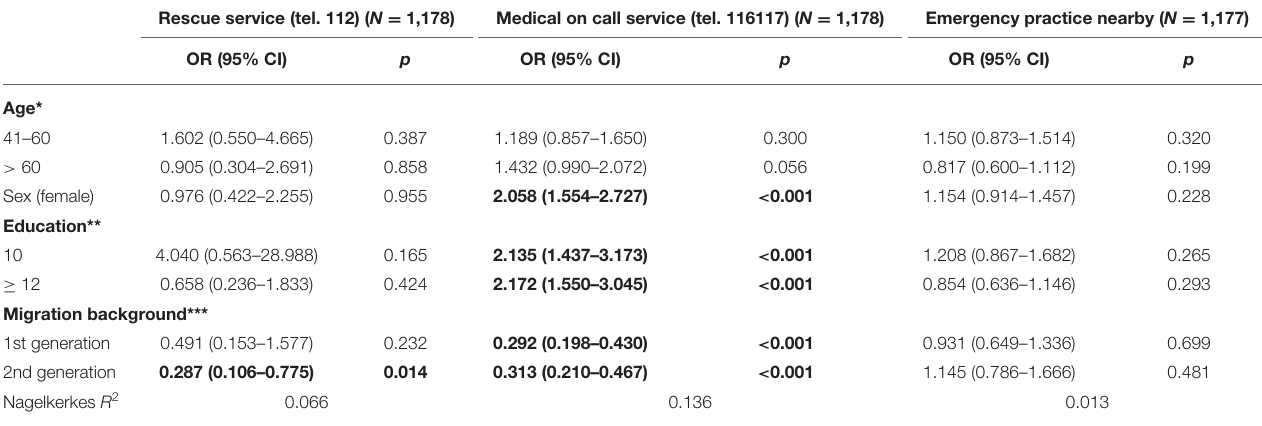
TABLE 2 | Knowledge of emergency care services according to social factors: logistic regression models. Rescue service (tel. 112) ( N =